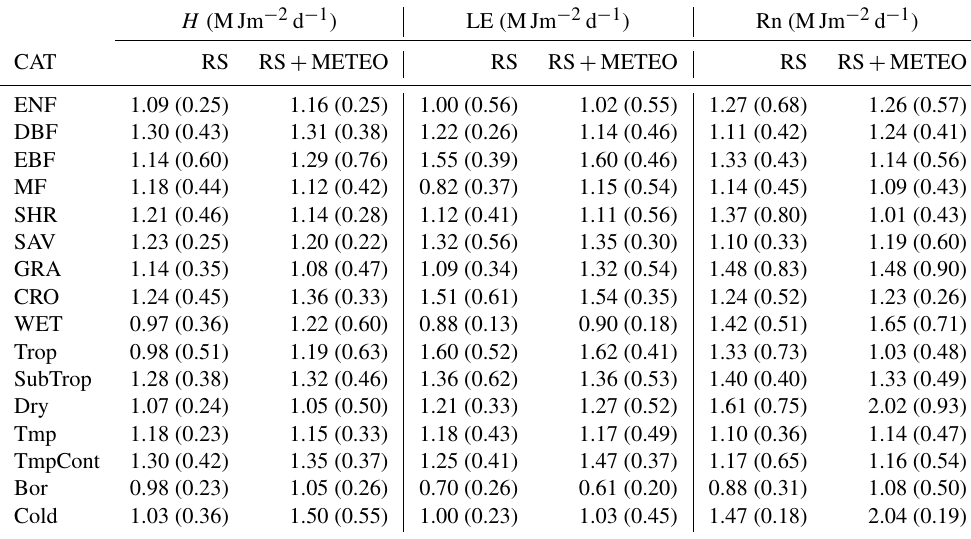
Table C5. Median site-by-site RMSE and its standard deviation (in parentheses and estimated as reported in Jung et al., 2009) for the energy fluxes per PFT and climate zone. List of acronyms: ENF, was evergreen needleleaf forest; DBF, deciduous broadleaf forest; EBF, evergreen broadleaf forest; MF, mixed forest; SHR, shrubland; SAV, savannah; GRA, grassland; CRO, cropland; WET, wetland; Trop, tropical; SubTrop, subtropical; Dry, dry and arid land; Tmp, temperate; TmpCont, temperate–continental; Bor, boreal; Cold, cold and polar environment or covered by ice.